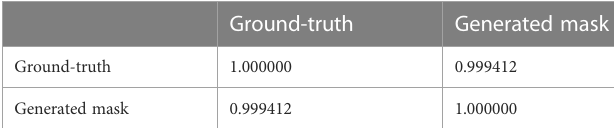
TABLE 3 Pearson correlation table between ground-truth and generated mask.